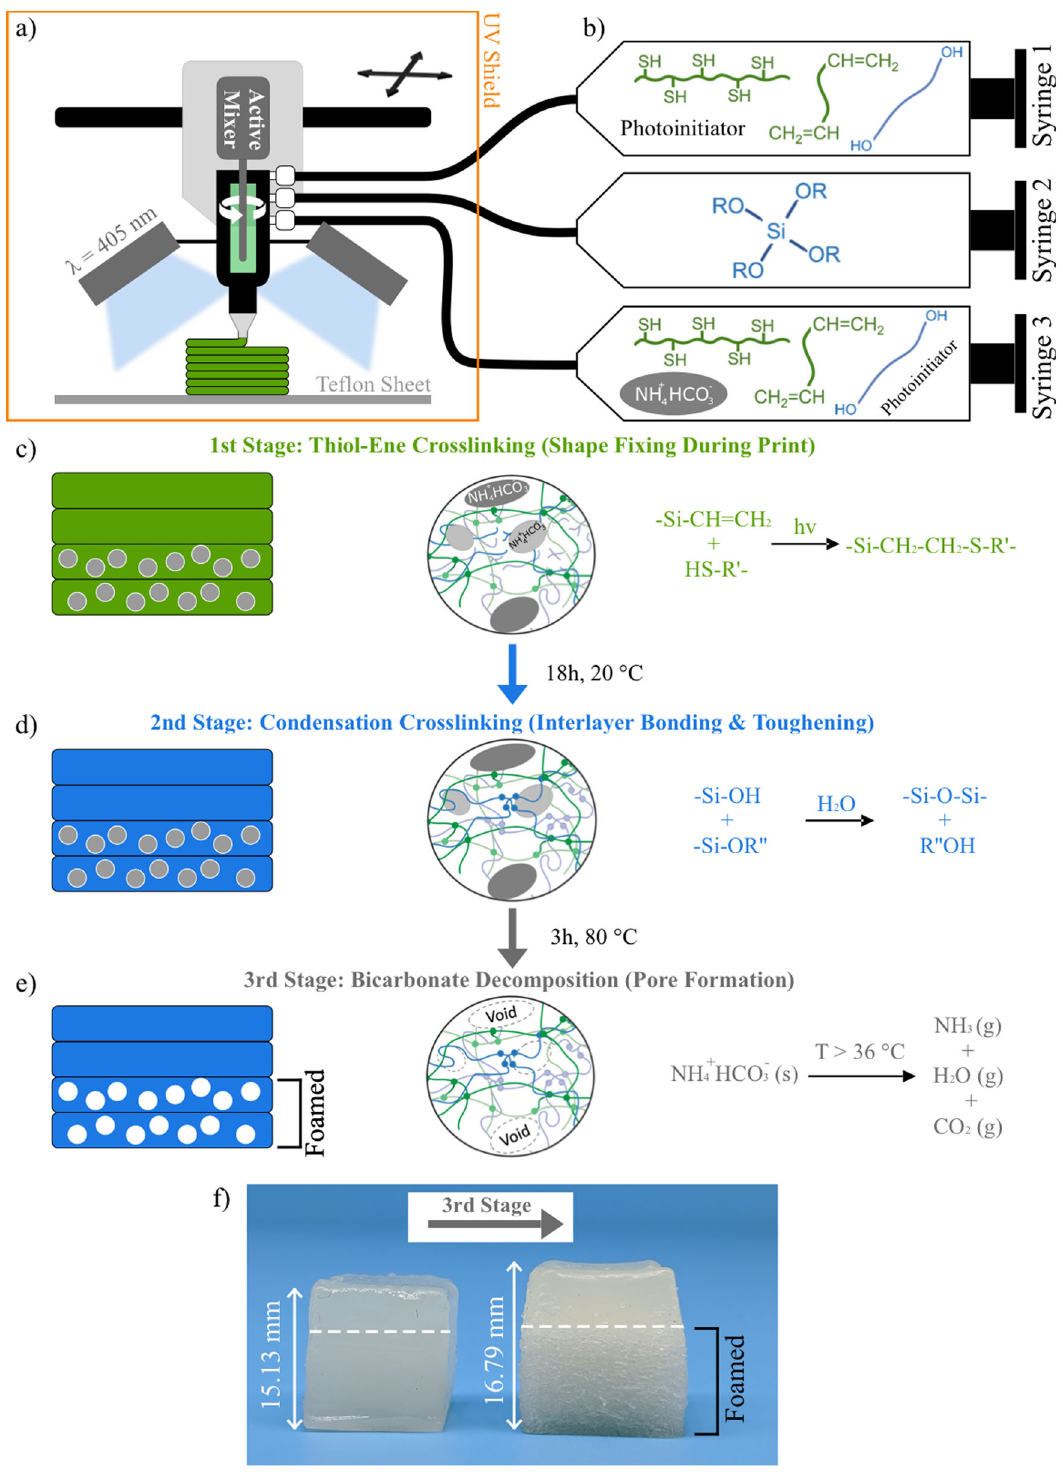
Fig. 1 Ultraviolet assisted direct ink writing. a Schematic illustration of the extruder design representing active mixing and photoirradiative curing. Layer by layer printed object colored as green to highlight immediate shape fi xing during print (green body formation) under near UV lights. Print bed covered with Te fl on sheet for easy removal of the fi nal object. b Compositions of the print materials located inside each syringe for multi-material printing. c Schematic illustration of green body formation represented with green color as the fi rst stage. d Schematic illustration of condensation curing represented with blue color as the second stage which completed after 18 h at 20 °C. e Schematic illustration of bicarbonate decomposition represented with the removal of gray ammonium bicarbonate particles between the layers located at the bottom as the third stage which completed after 3 h at 80 °C. Middle images at c , d , and e are illustrations of polymer chains for each stage. f Optical image of the third stage. 3D printed multi-material cube at the end of the second stage located on the left and at the end of the third stage on the right. Dashed line represents material change from foam into silicone region.